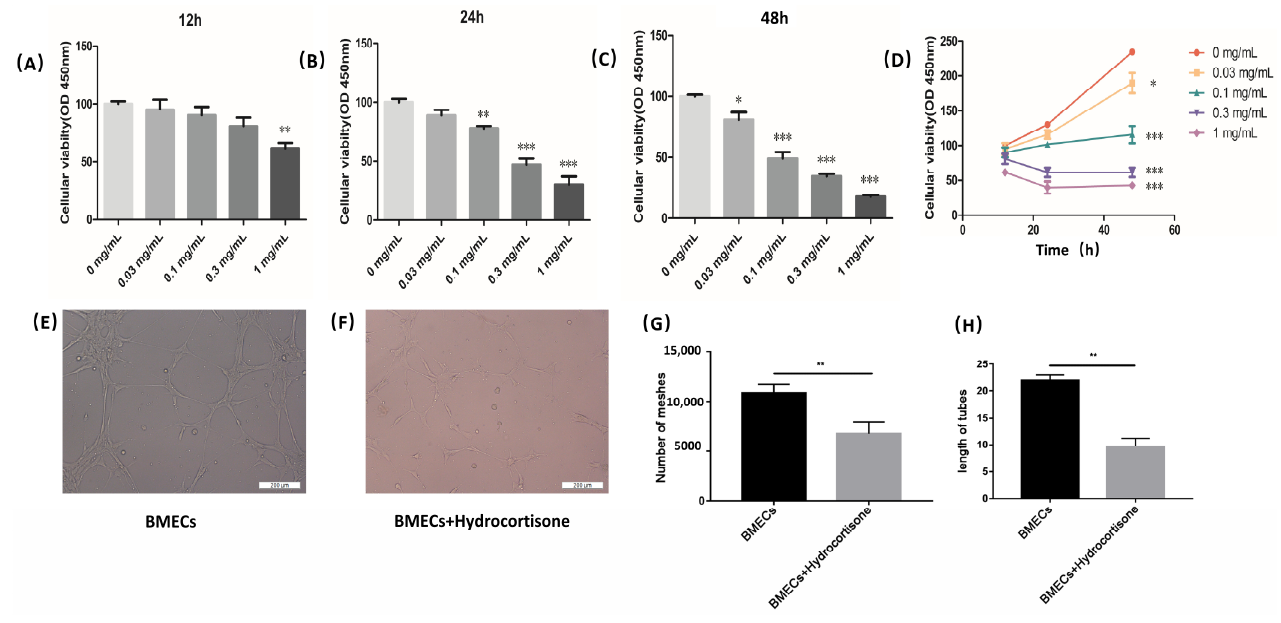
Figure 3. Hydrocortisone decreased BMECs’ viability. ( A – D ) CCK-8 was used to measure viability of BMECs treated with different concentrations of hydrocortisone for different times. ( E – H ) When 0.1 mg/mL of hydrocortisone was used to treat BMECs, the number of meshes and tube length of BMECs were signifi- cantly reduced, indicating that BMECs injury model was successfully established. OD value; * p < 0.05, ** p < 0.01, *** p < 0.005. Each bar represents the mean ± SD of three independent